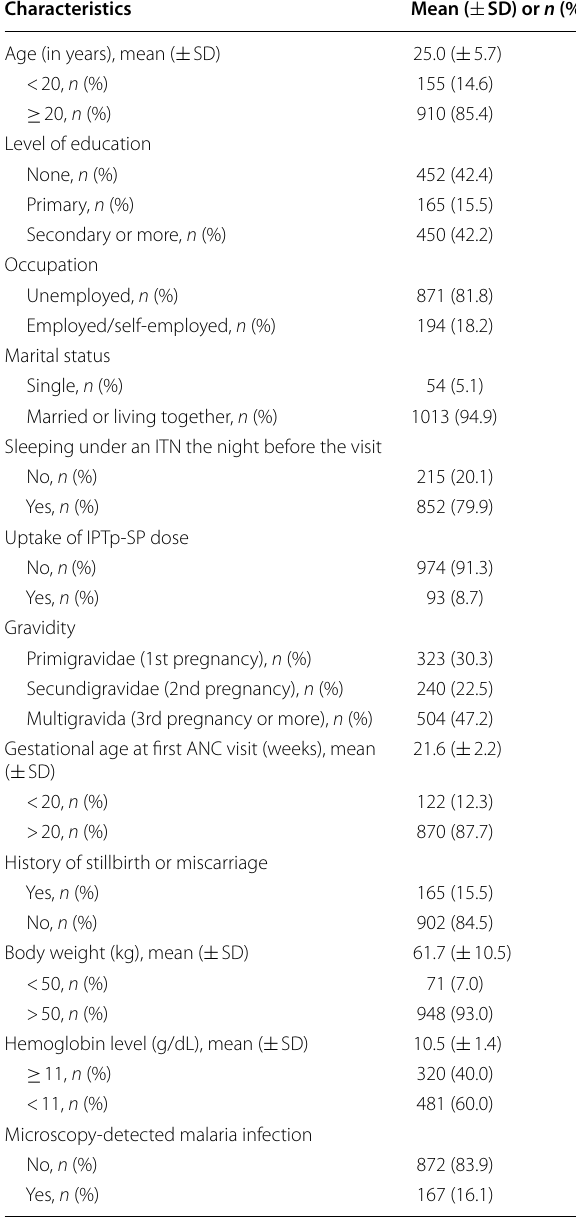
Table 2 Characteristics of first ANC attendees in the Yako health district, Burkina Faso ( n =